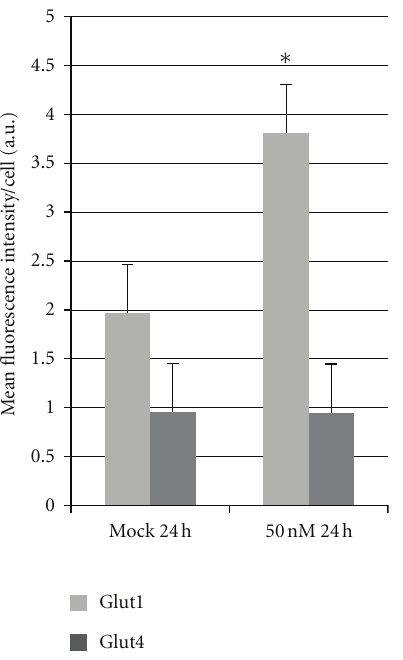
Figure 4: C2C12 cells were seeded onto chamber slides and allowed to di ff erentiate from myoblasts to myotubes as described in the Materials and Methods section. Myotubes were then transfected at each concentration of siRNA (SI00906220) (0 and 50 nM) and collected at the designated time point (24 h). After transfections, cells underwent standard immunofluorescence processing and were imaged. Each sample was compared to negative and positive controls, which were used to quantify the image results ( ∗ P < 0 . 05).